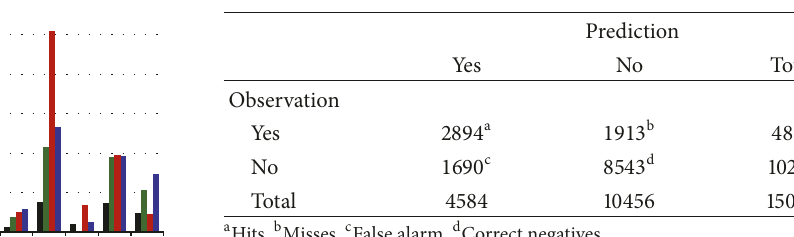
Table 4: Contingency table for year 1987 corresponding to the rainfall anomaly threshold of − 0.1mm/day for